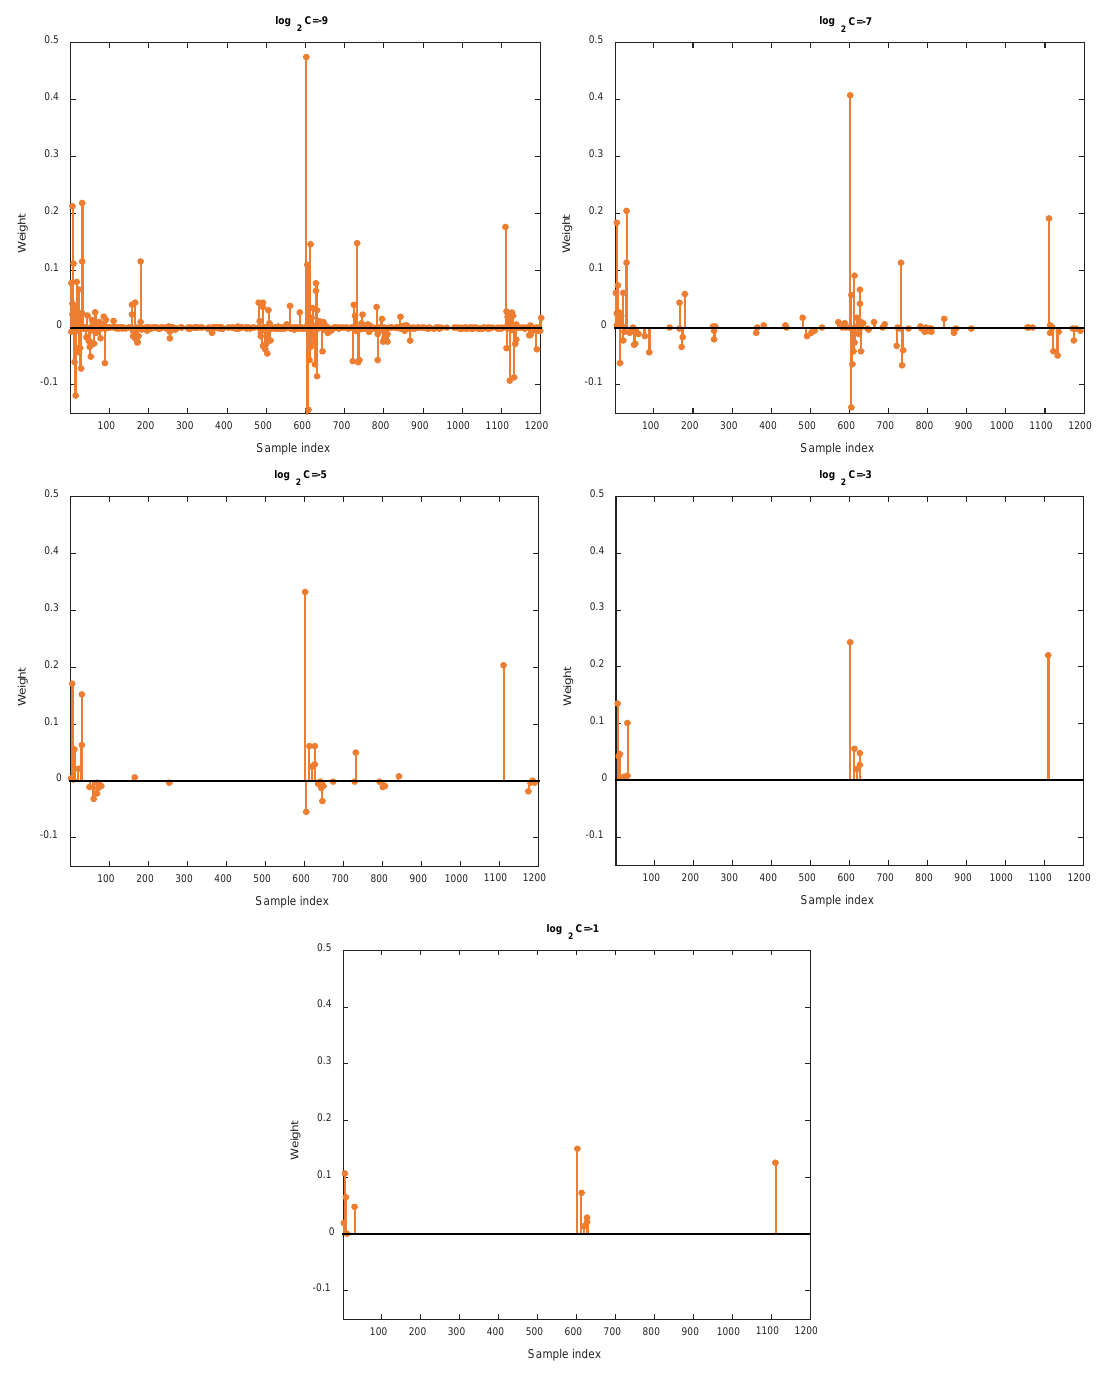
. Figure 10. Variation of sparsity w.r.t. different values of C 𝐶𝐶